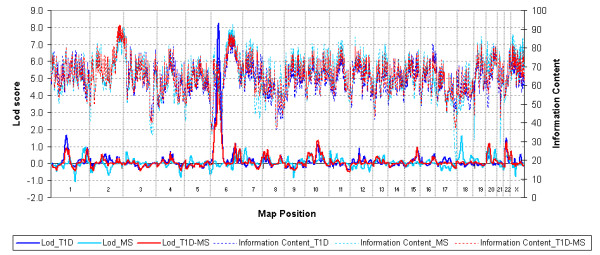
Non-parametric linkage analysis in T1D_SCAN, MS_SCAN and T1D-MS_SCAN. Reading from the left Y-axis, LOD score results are shown for each chromosome, proceeding from the short-arm telomere to the long arm telomere. The right Y-axis reports the corresponding information content for each point. The T1D and MS sample sets are described in the Materials and Methods section.